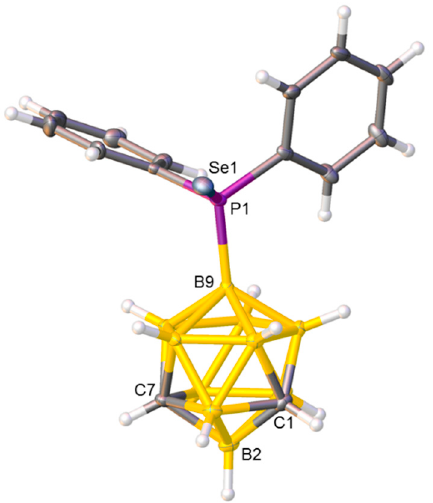
Figure 3. Molecular structure of compound 3 . Selected interatomic distances (Å): B9 − P1 1.937(2) and P1 − Se1 2.1196(5).